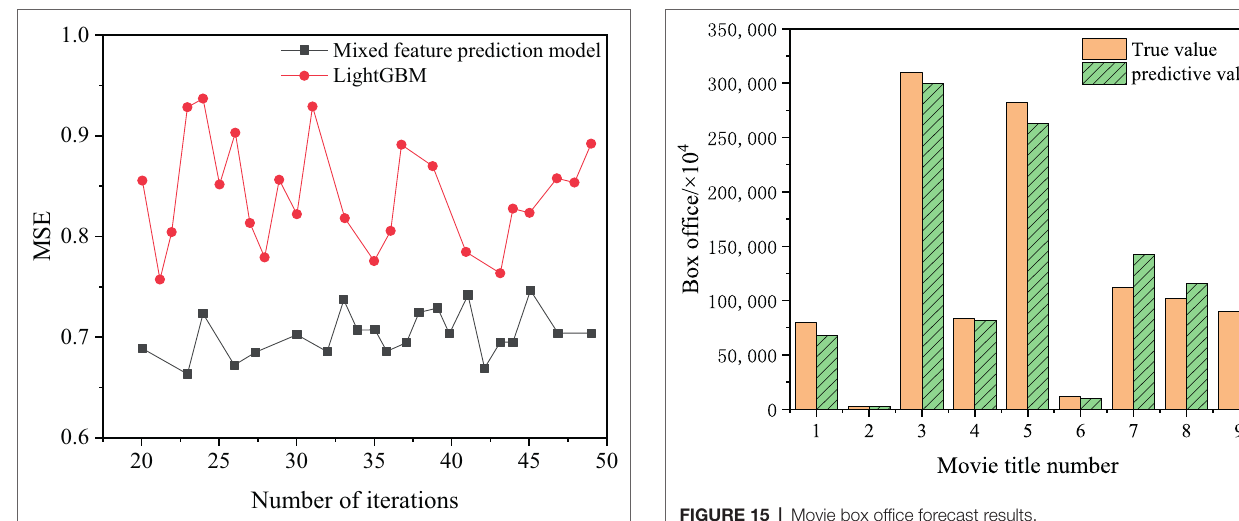
FIGURE 15 | Movie box office forecast